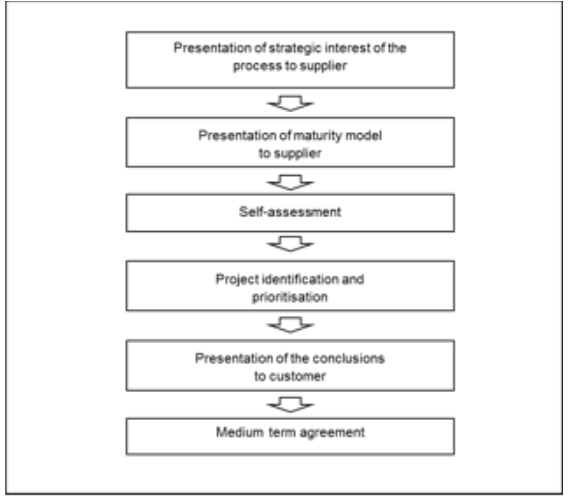
Figure 2. Self-assessment and project definition